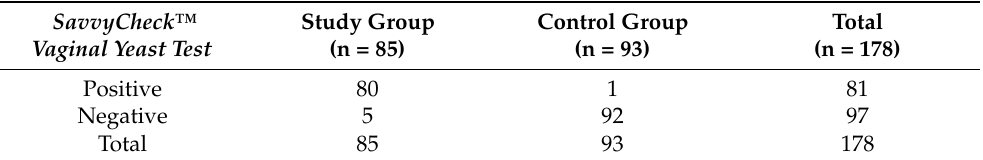
Table 2. Validation of the SavvyCheck ™ Vaginal Yeast Test in comparison to Gram-stained smears in a total of 178 asymptomatic pregnant women who were screened for VVC. SavvyCheck ™ Vaginal Yeast